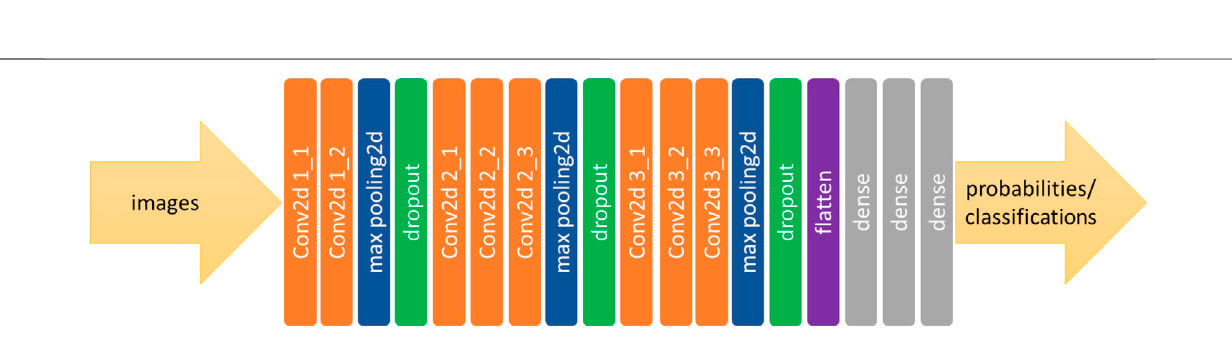
FIGURE 3 | The CNN model